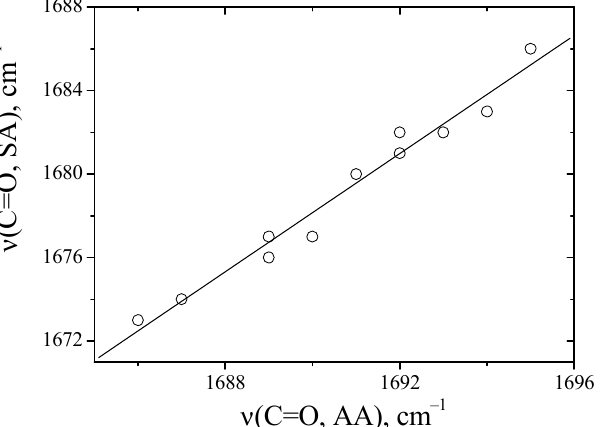
Figure 3. A comparison of the absorption frequencies of C=O groups between alanine (AA) and sarcosine anhydride (SA) in solvents, values correspond to the data in Table 1.